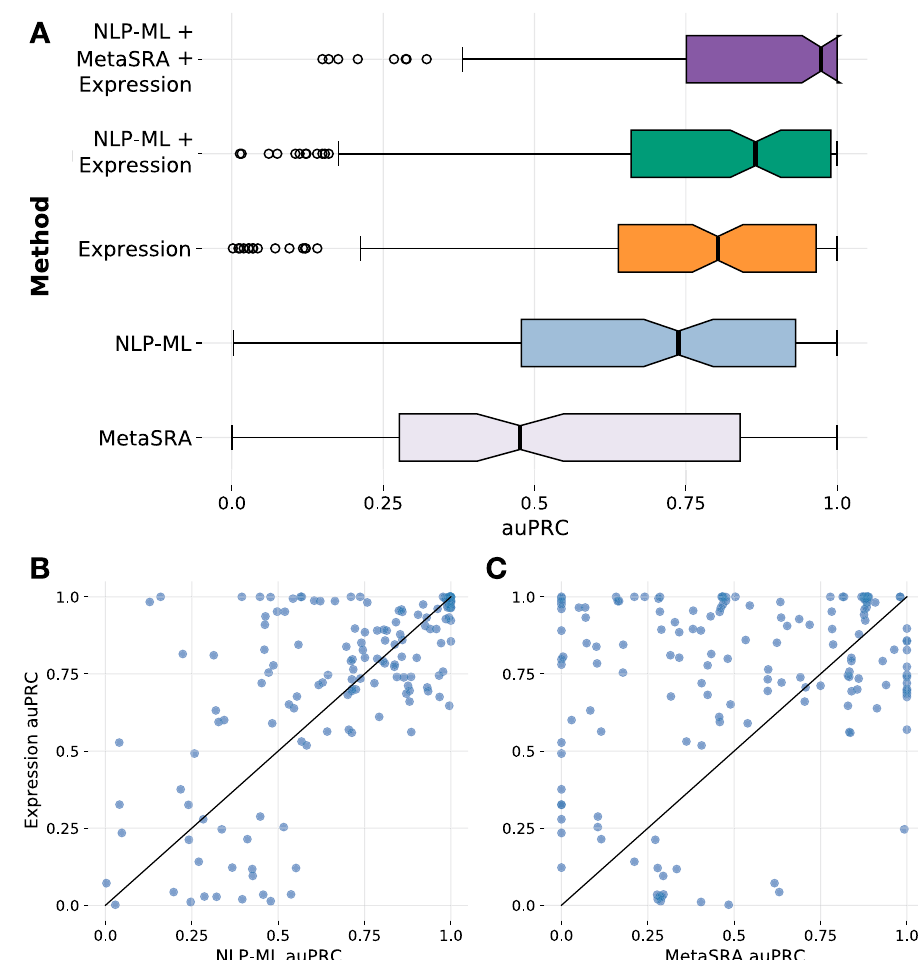
Fig. 6 | NLP-ML models are nearly as accurate as expression-based models in predicting tissue source of transcriptome samples, and combining them is better than either. A Distribution of the area under the precision-recall curve (auPRC)scoresacross153tissuesforthetwotop-performingtext-basedmethods — MetaSRA and NLP-ML — and for the method based on expression pro fi les ( ‘ Expres- sion ’ ) for sample tissue classi fi cation. Also shown are the distributions of auPRC scores for combining the predictions of Expression with NLP-ML ( ‘ NLP-ML+ Expression ’ ) and with NLP-ML and MetaSRA ( ‘ NLP-ML+MetaSRA+Expression ’ ). Each point in the boxplot (in a different color; de fi ned as in Fig. 2) is the